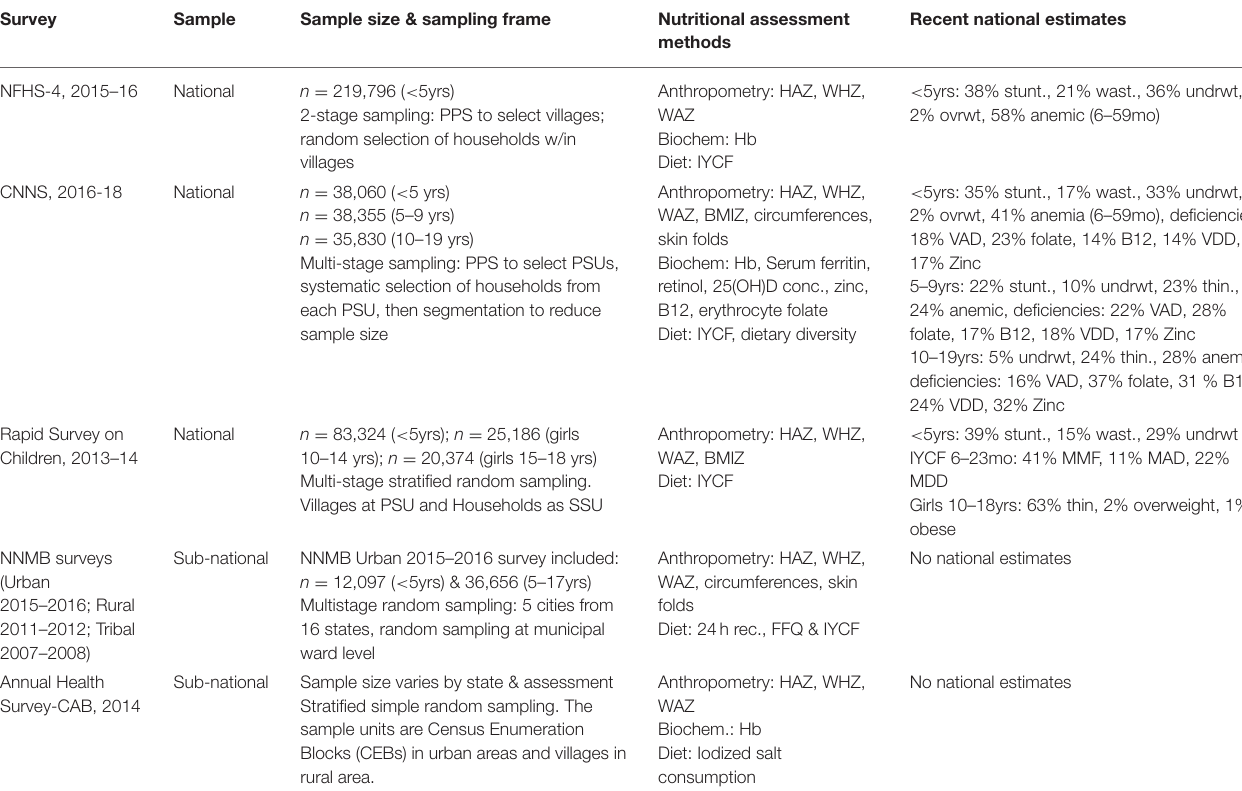
TABLE 1 | National & sub-national surveys that assess the nutrition of children & adolescents in India.